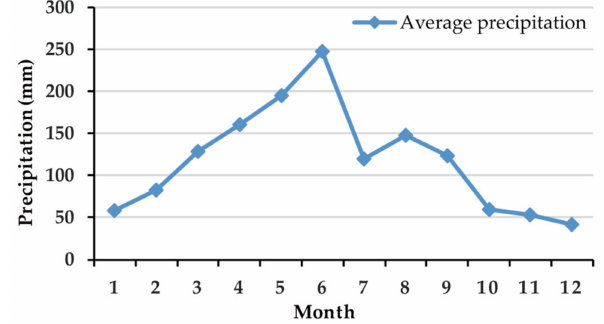
Figure 2. Monthly average precipitation from 2011 to